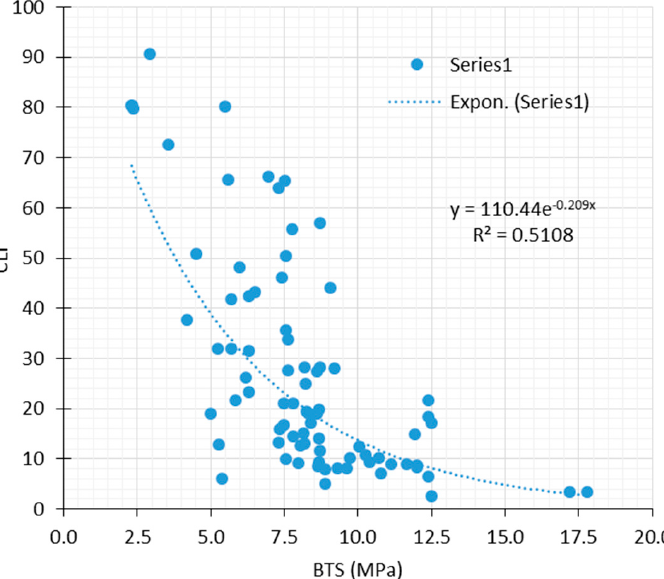
Figure 8. Relations between the BTS and CLI.